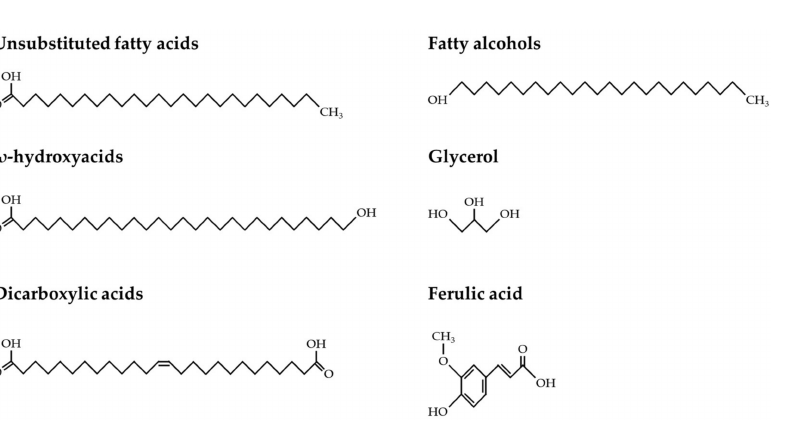
Figure 1. The typical monomers that build the suberin polymer in plants. Chemical formulas of constituents of the suberin polyaliphatic domain: unsubstituted fatty acids, ω -hydroxyacids, dicarboxylic acids and fatty alcohols and glycerol polymer (the major backbone of suberin). The chemical formula of ferulic acid, the most abundant monomer of the suberin polyphenolic domain, is also